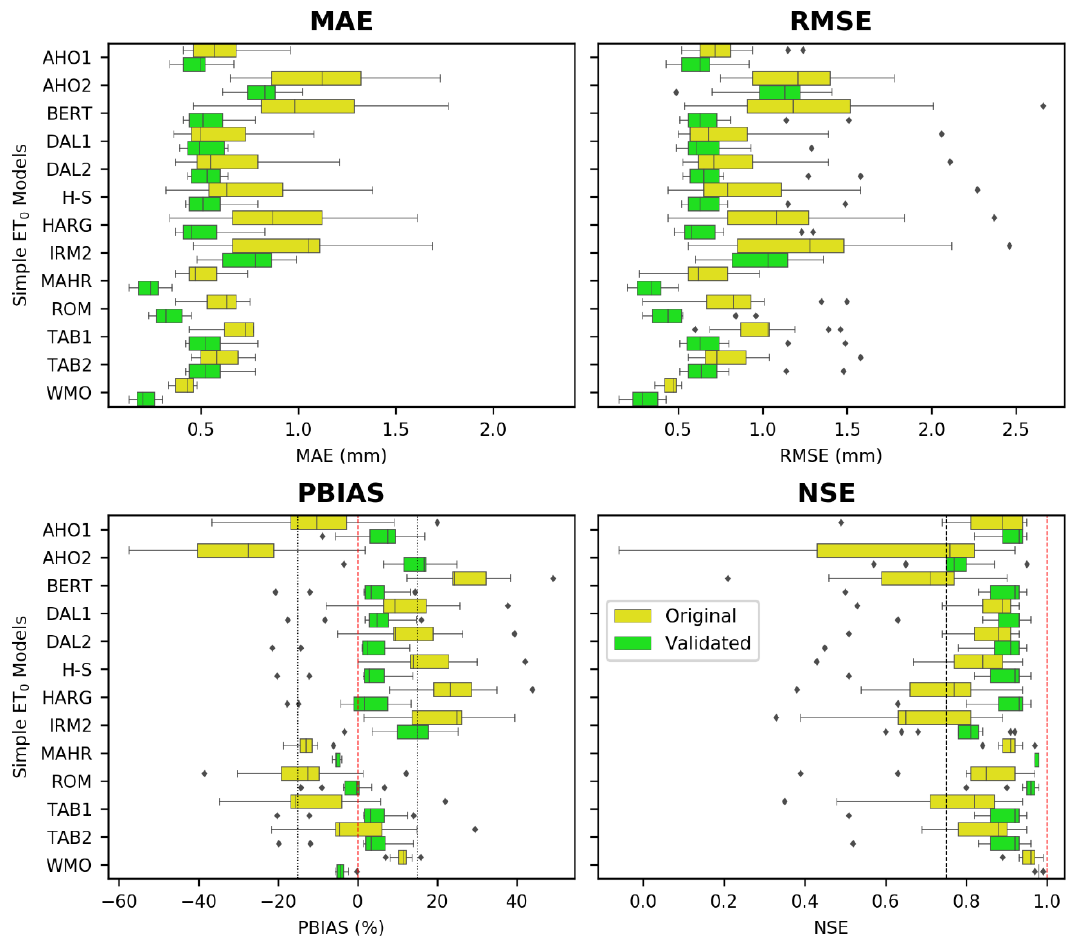
Figure 8. Performance of the 13 validated models on a monthly timescale over the period 2000–2017. The models are assessed through the MAE , RMSE , PBIAS and NSE metrics respectively.